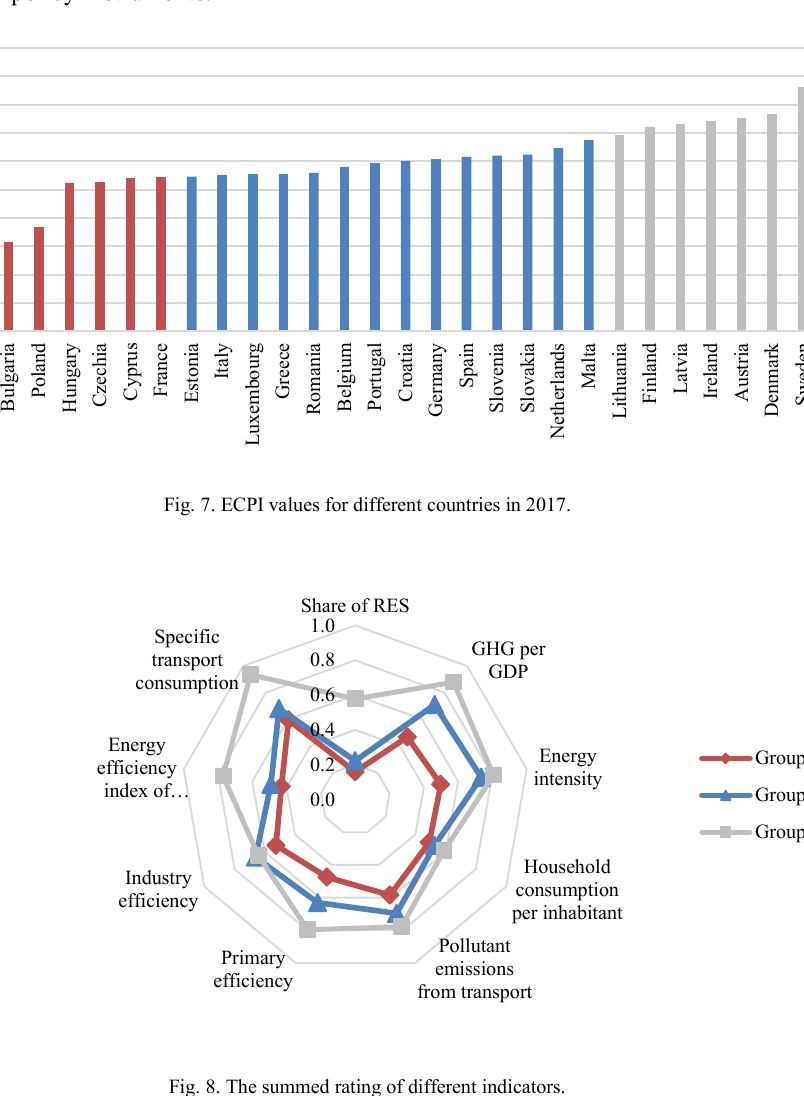
Fig. 8. The summed rating of different